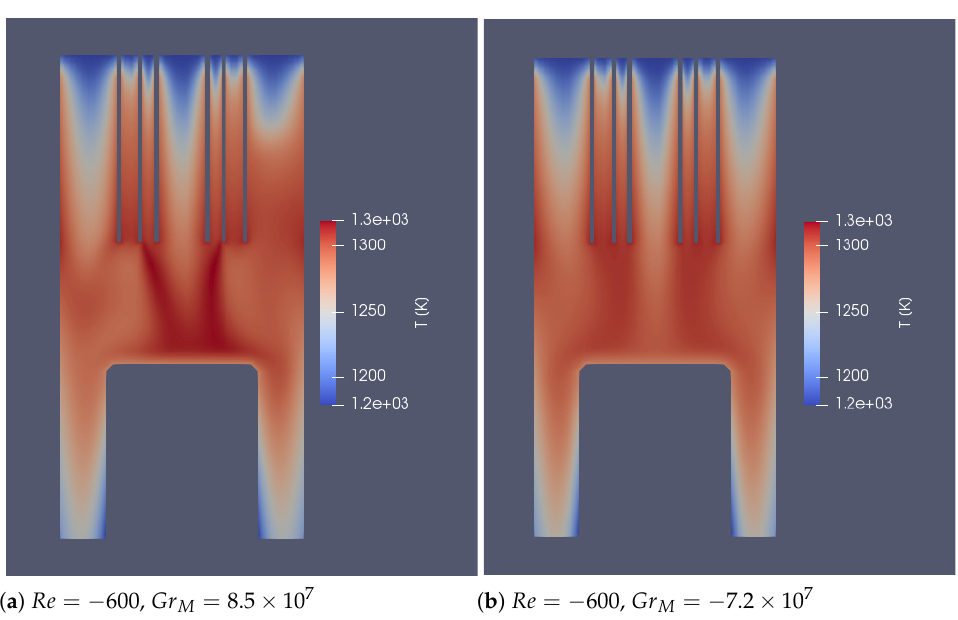
Figure 10. Vertical cut through the down-flow reactor depicting the temperature distribution. ( a ) Vari- ation of NH 3 in the ORL . ( b ) Variation of H 2 in the IRL